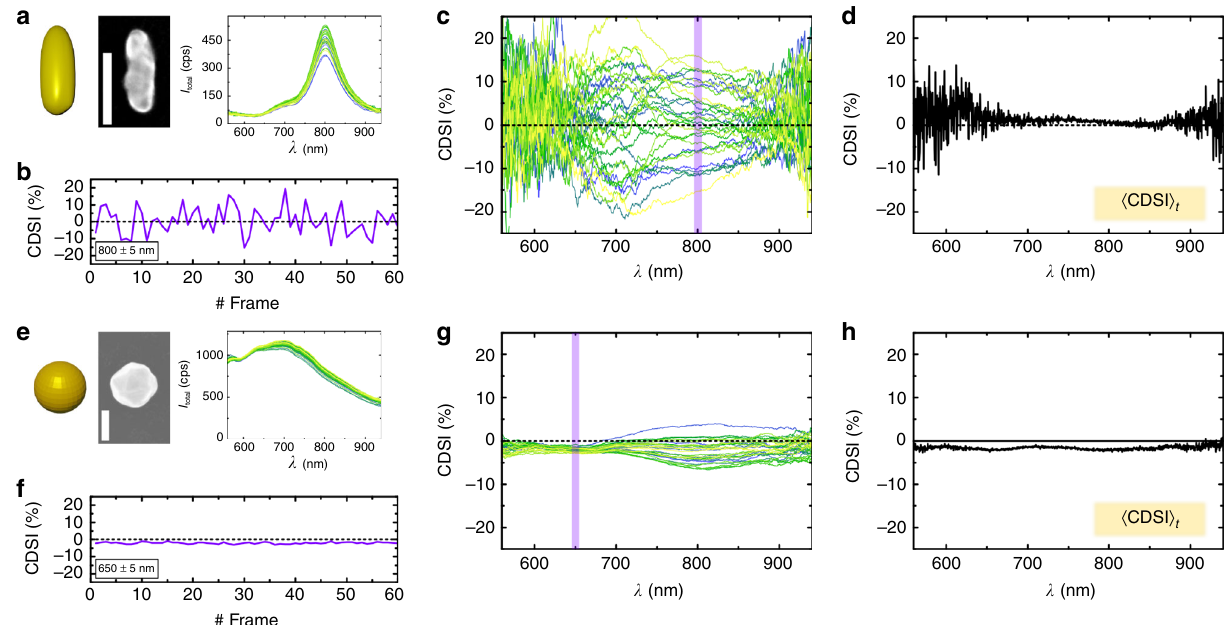
Fig. 3 Chiroptical spectroscopy of a freely diffusing single Au nanorod and Au nanosphere. a Schematic, SEM (scale bar 100 nm) and total scattering intensity spectra of a single Au nanorod. b Frame-wise CDSI signal at scattering resonance ( λ = 800 ± 5 nm) of the Au nanorod moving under random Brownian motion. c Full CDSI spectra of an Au nanorod, acquired subsequently and thus with different stationary orientations. The purple vertical line indicates the spectral region shown as a time-trace in ( b ). d 〈 CDSI 〉 t measured on an Au nanorod and averaged over t = 60 frames from ( c ). e Schematic, SEM (scale bar 100 nm) and total scattering intensity spectra of a single Au nanosphere. f Frame-wise CDSI signal at scattering resonance ( λ = 650 ± 5 nm) of the Au nanosphere moving under random Brownian motion. g Full CDSI spectra of an Au nanosphere, again shown for subsequent acquisitions. Again, the purple vertical line indicates the spectral region shown as a time-trace in ( f ). h 〈 CDSI 〉 t measured on an Au nanorod and averaged over t = 60 frames from ( g